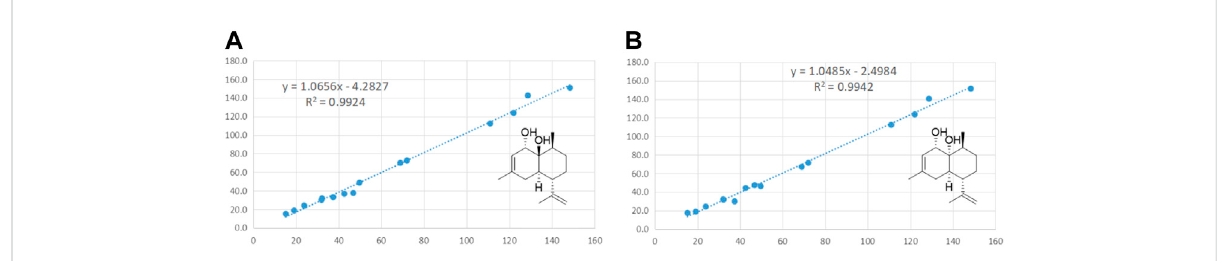
FIGURE 6 Linear regression fi tting of computed 13 C-NMR chemical shifts of the calculated con fi guration of compound 6 with the experimental values.